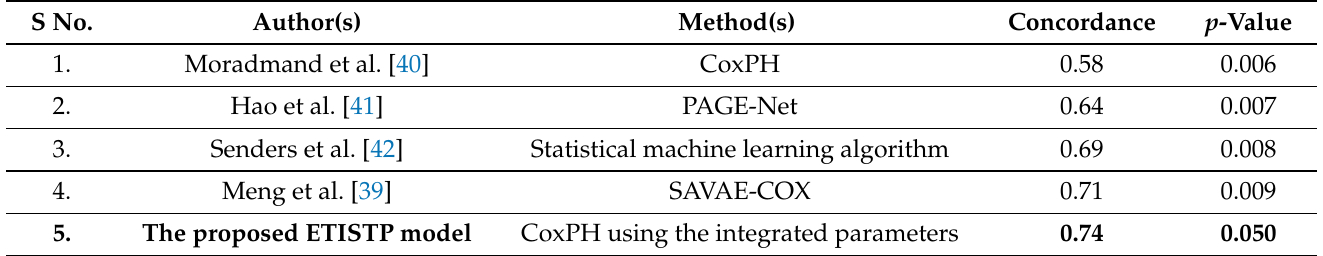
Table 13. Patient’s survival prediction based on the Brats2020 dataset.